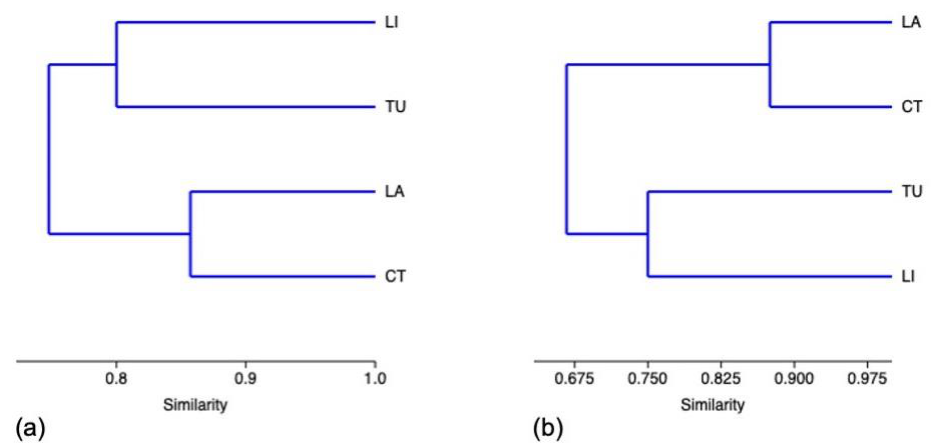
Figure 7. Cluster analyses for plastic debris. ( a ) Similarities between plastics by shape and ( b ) the similarities between plastics by